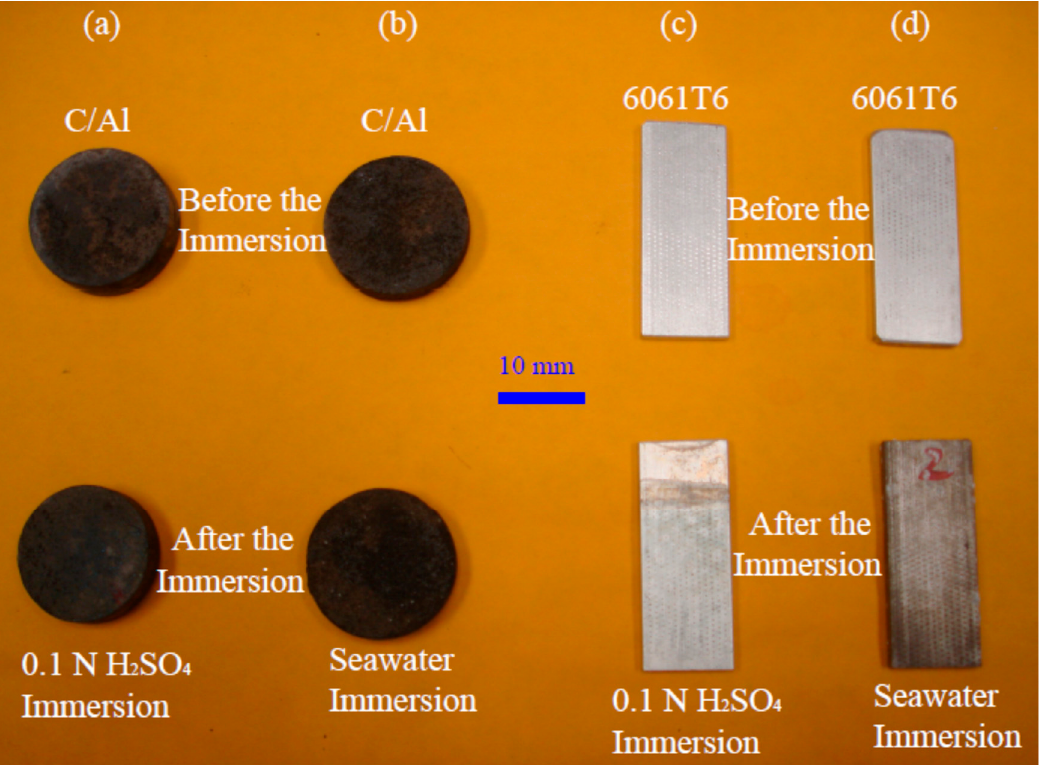
Figure 7. Optical images taken from the surface of the C/Al composite and 6061 showing the general morphology of the materials before and after immersion tests: ( a ) C/Al composite before and after immersion 0.1 N sulfuric acid, ( b ) C/Al composite before and after immersion in seawater, ( c ) 6061 before and after immersion 0.1 N sulfuric acid, and ( d ) 6061 before and after immersion in seawater.